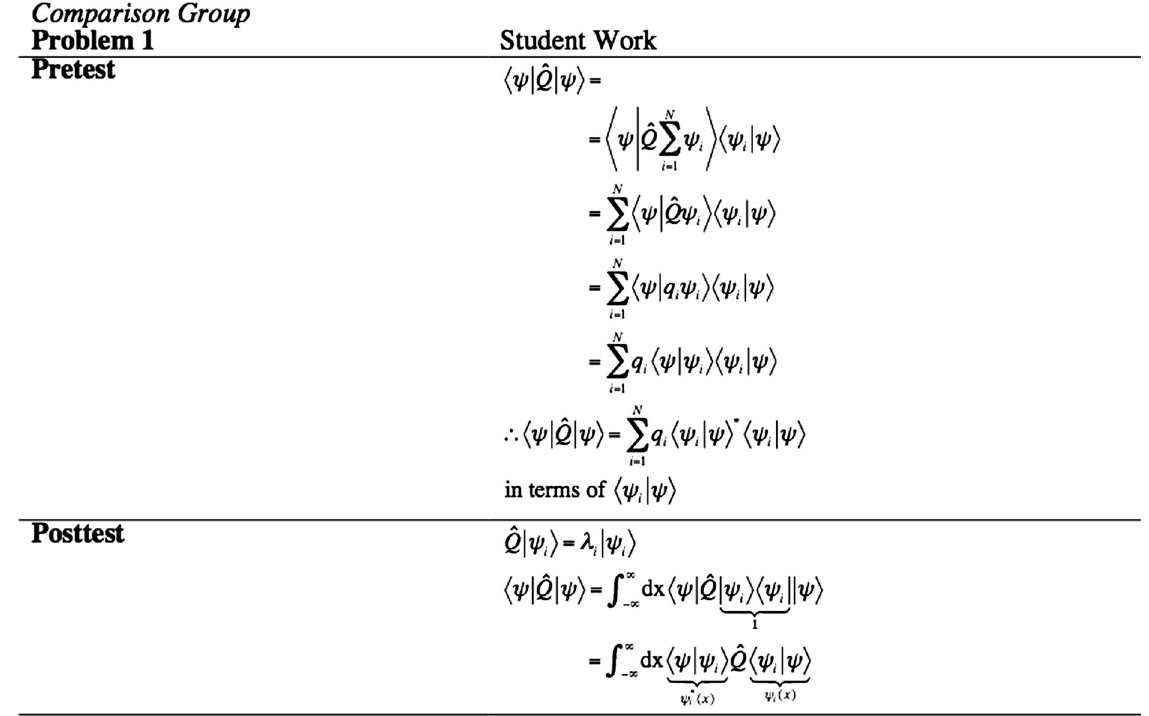
FIG. 3. An example of a pretest and posttest solution pair for a student from the comparison group which demonstrates a typical deterioration on the expectation value problem. The pretest and posttest scores are 100% and 50% for invoking, 89% and 33% for applying, and 95% and 42% for the overall scores, respectively. While the pretest solution is almost perfect, the posttest solution shows ˆ Q and the continuous spectrum of position student difficulties including confusion between the discrete spectrum of the eigenstates of ˆ eigenstates and difficulty with the treatment of the operator